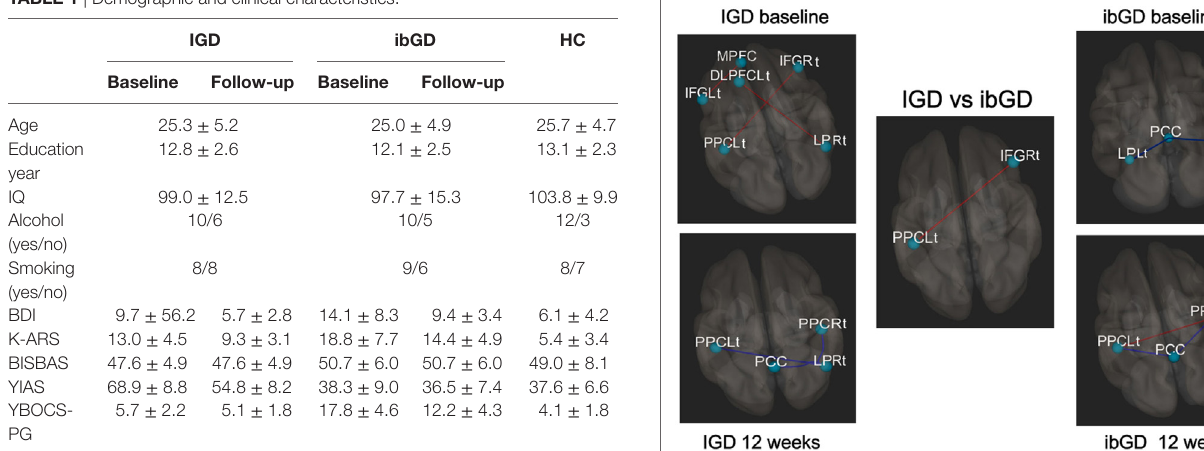
TaBle 1 | Demographic and clinical